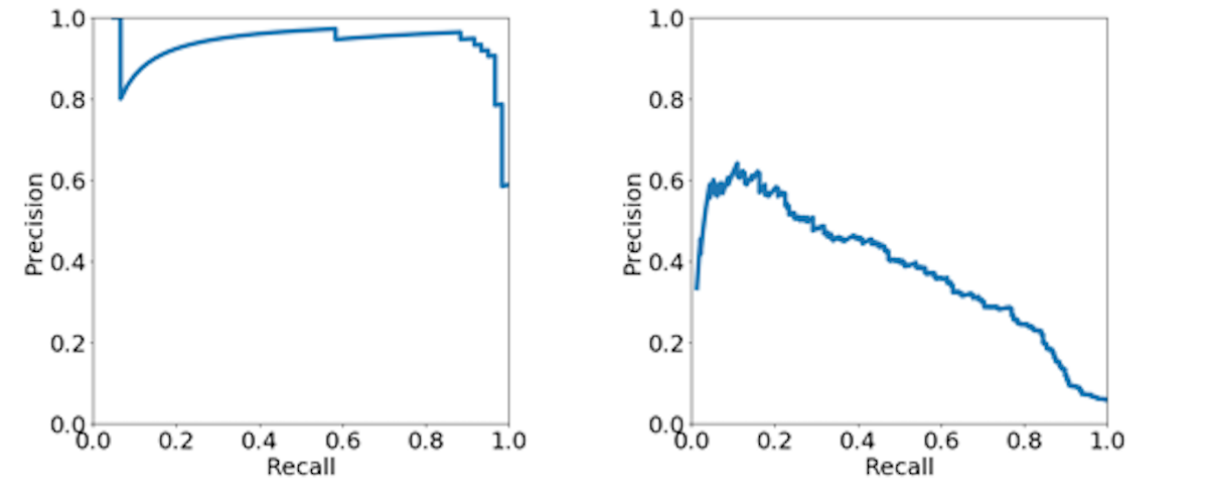
Figure 2. Precision-recall curves for (a) ADE-containing article extraction and (b) ADE-suggesting sentence extraction. ADE: adverse drug